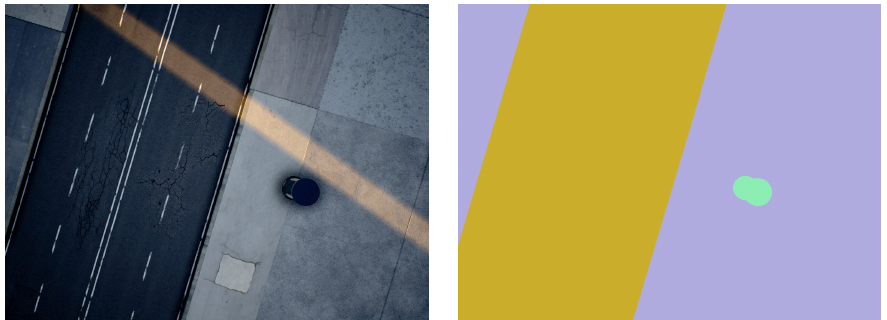
Figure 5. Low-altitude urban scene captured with a downward-looking camera. On the left is a simulated image. On the right is the corresponding segmented